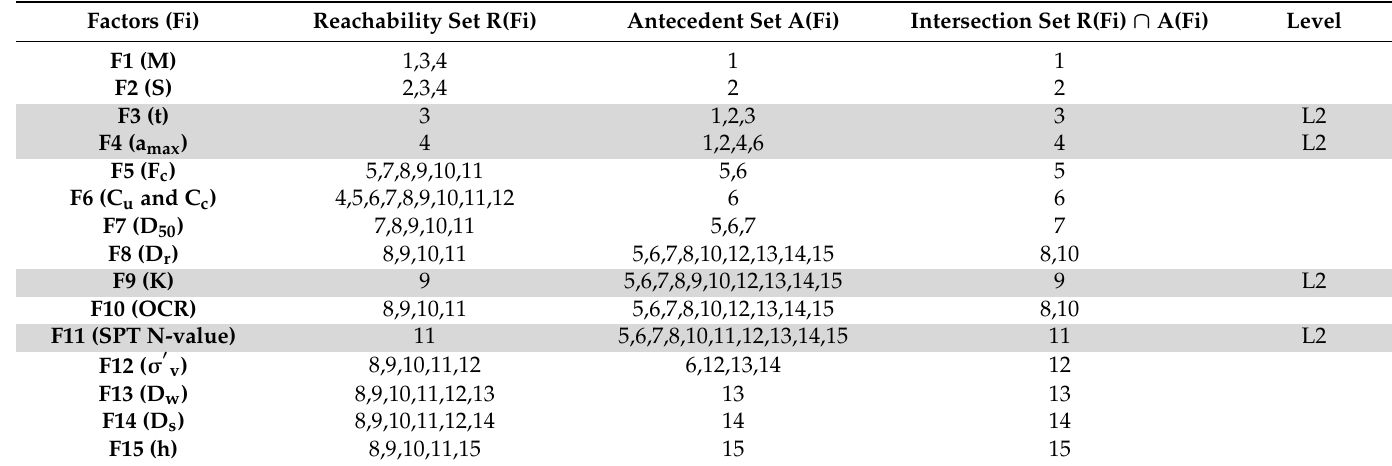
Table A4. Level partition—Iteration 2.